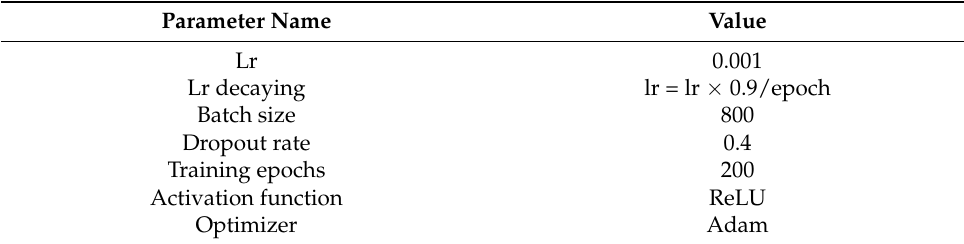
Table 4. Optimal parameter values for the LSTM.